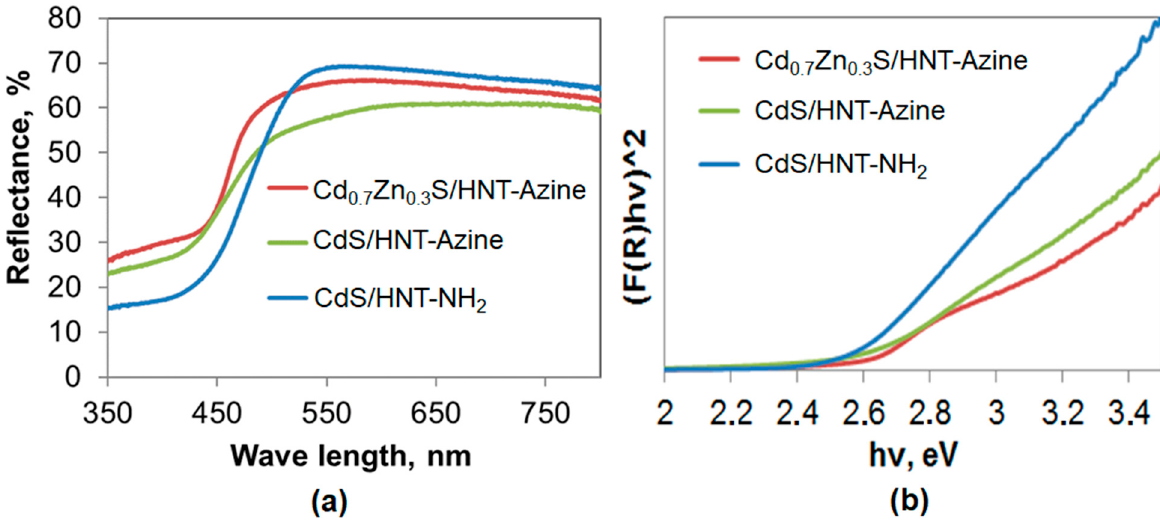
Figure 3. ( a ) UV-Vis diffuse reflectance spectra of CdS/HNT-Azine, Cd 0.7 Zn 0.3 S/HNT-Azine, and CdS/HNT-NH 2 ; ( b ) The Tauc plot for CdS/HNT-Azine, Cd 0.7 Zn 0.3 S/HNT-Azine, and CdS/HNT-NH 2 .